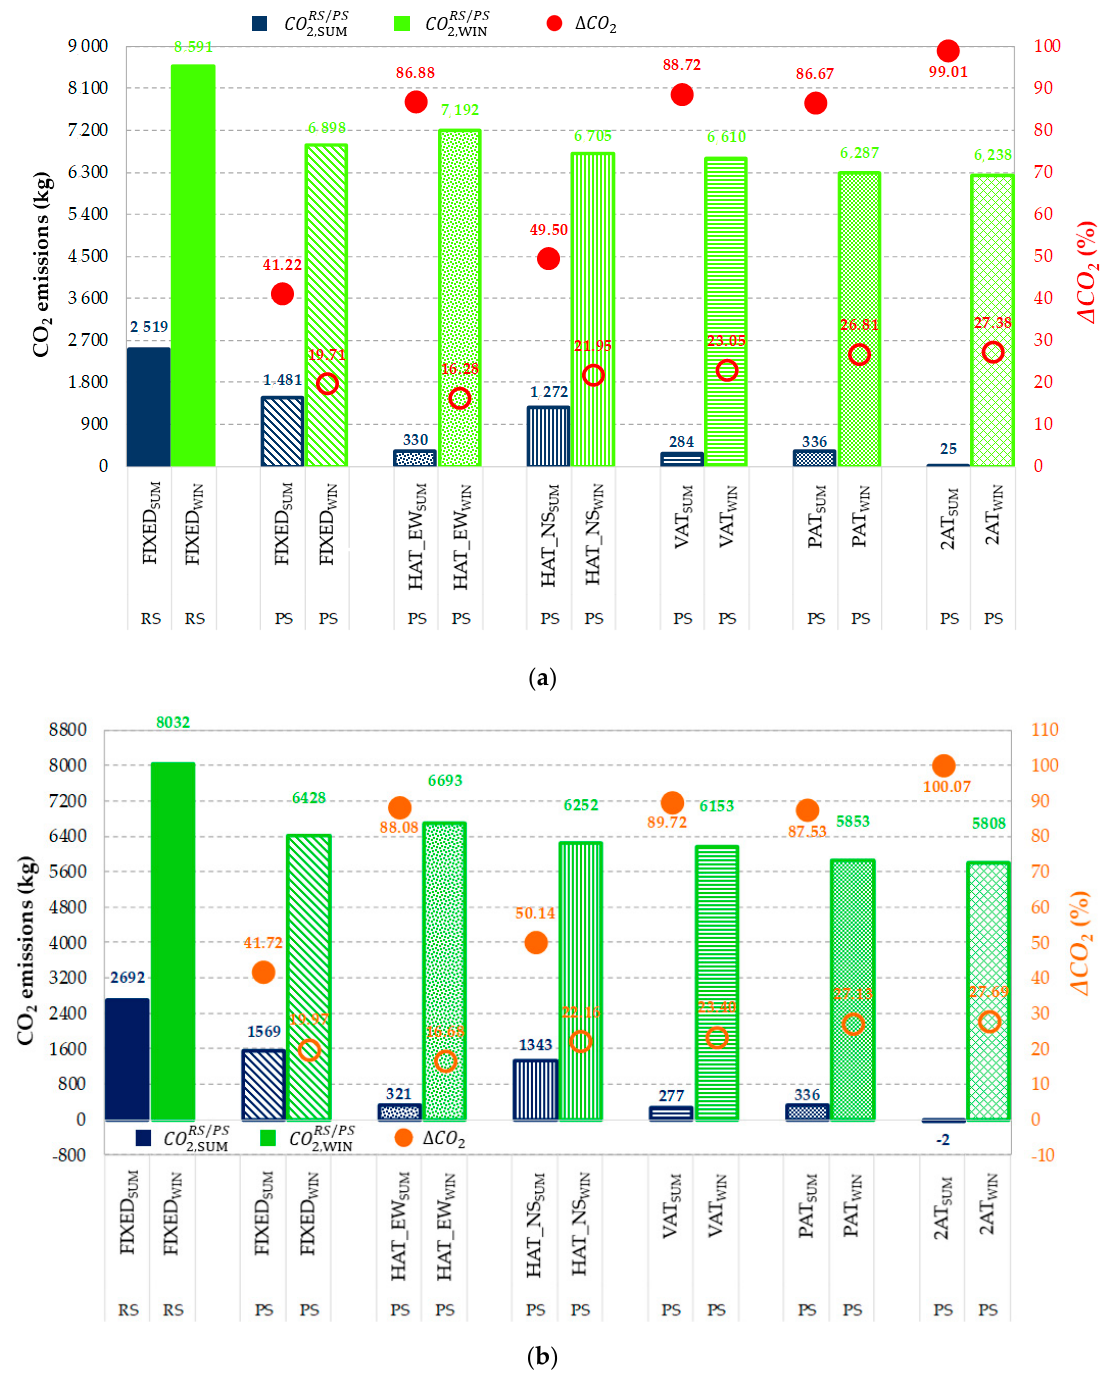
∆ CO 2 index in Scenario_MV ( a ) and Scenario_YV ( b